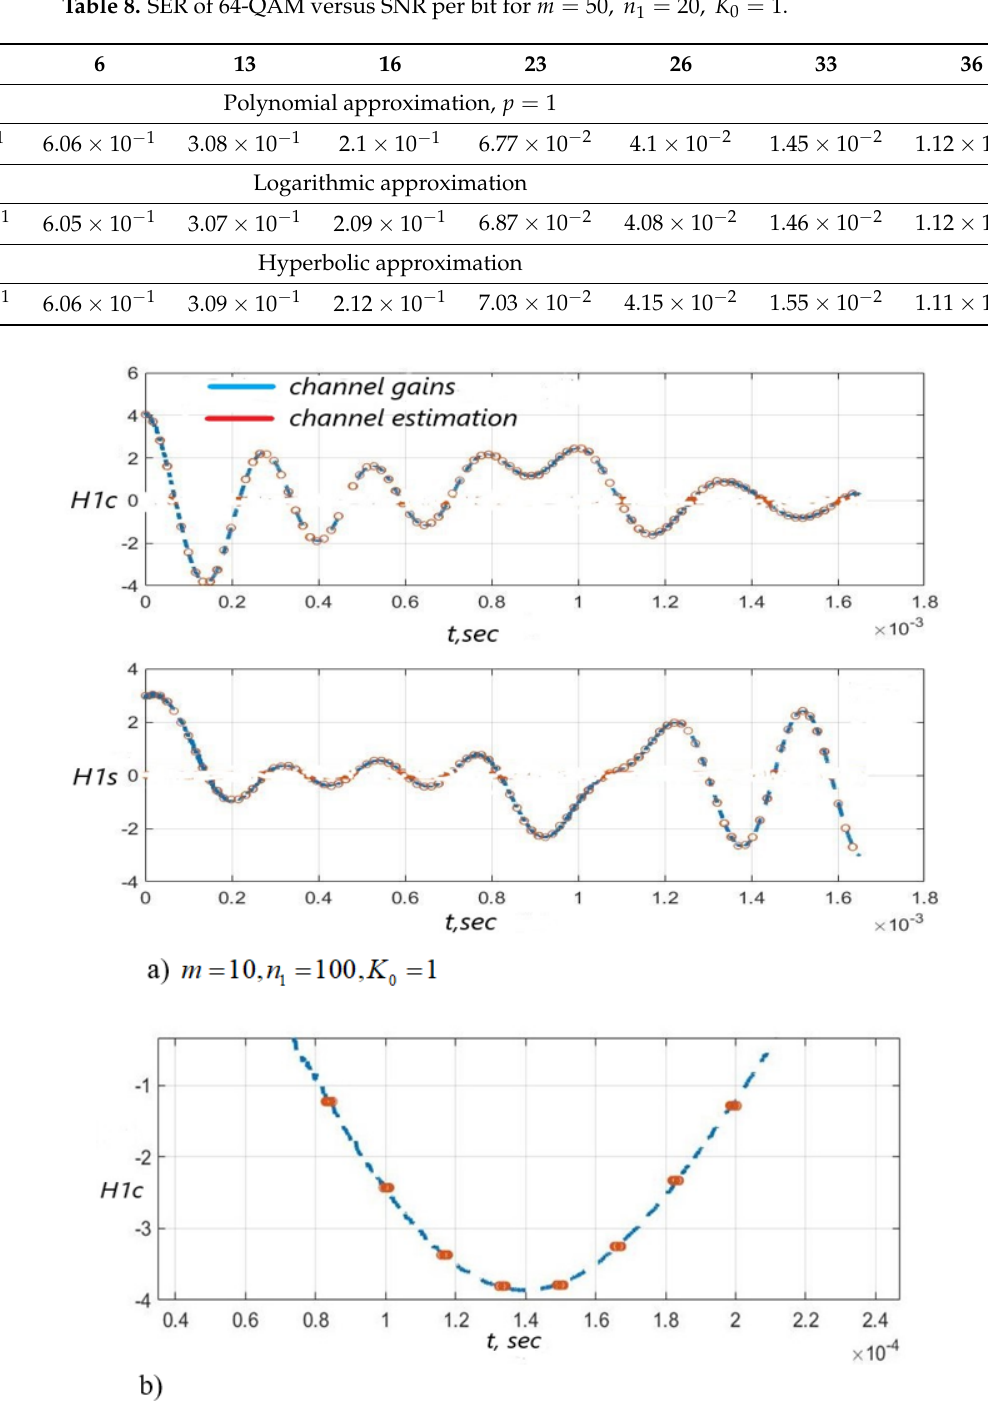
( ), ( ) H i H i and their estimation based on the test signal versus time: Figure 11. Channel gains Figure 11. Channel gains H 1 c ( i ) , H 1 s ( i ) and their estimation based on the test signal versus time: 1 1 c s the algorithms, described by Equations (5)–(9) and (12) with p = 0 was used—( a ), SNR = 26 dB; the the algorithms, described by Equations (5)–(9) and (12) with 0 p = was used—( a ), SNR = 26 dB; enlarged fragment of ( a , b the enlarged fragment of ( a , b ).